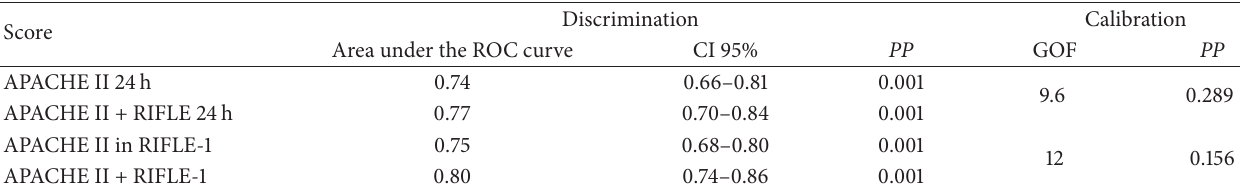
Table 4: Comparative analysis of discrimination and calibration of APACHE II in predicting mortality in the ICU alone and when combined with the RIFLE score calculated within 24 hours after ICU admission and on the Day of AKI.